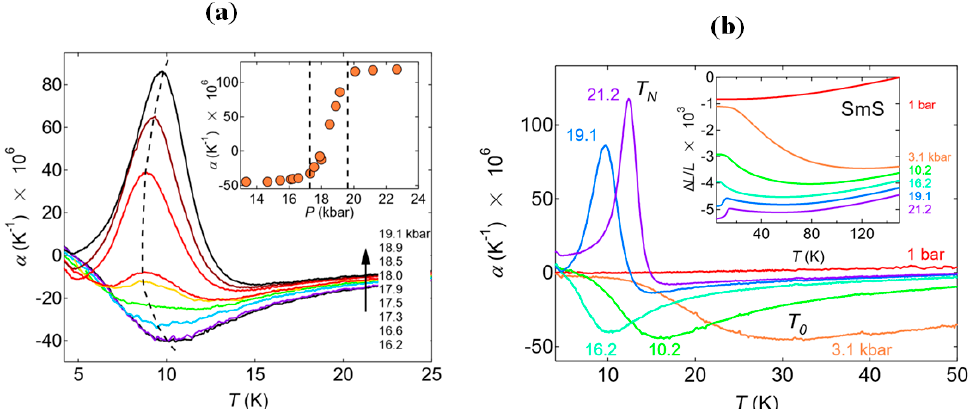
Figure 8. ( a ) Temperature dependence of the thermal expansion coefficient at pressures up to 21.2 kbar (2.12 GPa), with T 0 and T N corresponding to shallow negative and sharp positive peaks, respectively and a Δ L/L(T) graph in the inset. Data have been shifted by the authors for clarity; ( b ) A similar graph at pressures between 16.2 and 19.1 kbar (1.62–1.91 GPa). The area which is created by the two vertical dashed lines in the inset demonstrates the mixed phase regime. (Reprinted with permission from [13].)